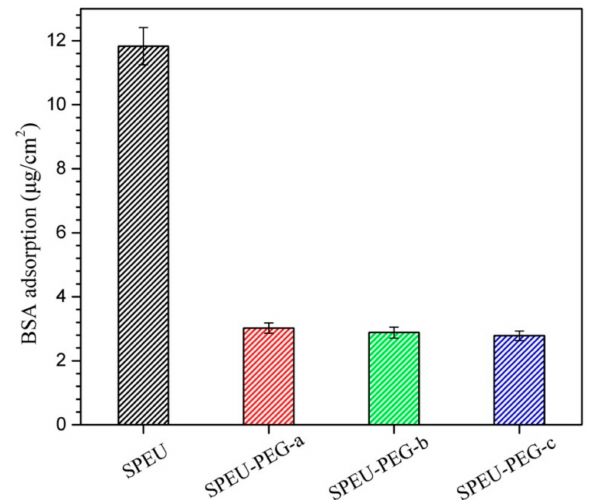
Figure 7. Adsorption behaviors of BSA on the surface of blank and PEG-grafted SPEU films at 37 ± 0.5 ◦